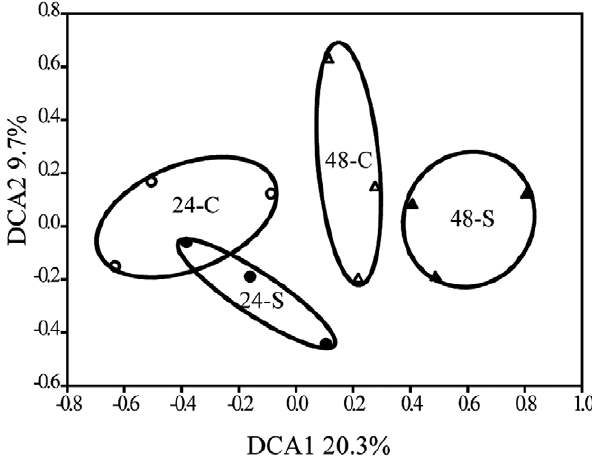
Figure 3. Detrended correspondence analysis (DCA) of control- and EcO157-inoculated spinach biofilm communities based on the all detected probes. 24-C, control biofilm community at 24 h N ( # ); 48-C, control biofilm community at 48 h ( D ); 24-S, EcO157- ); 48-S, EcO157-inoculated inoculated biofilm community at 24 h ( biofilm community at 48 h ( m